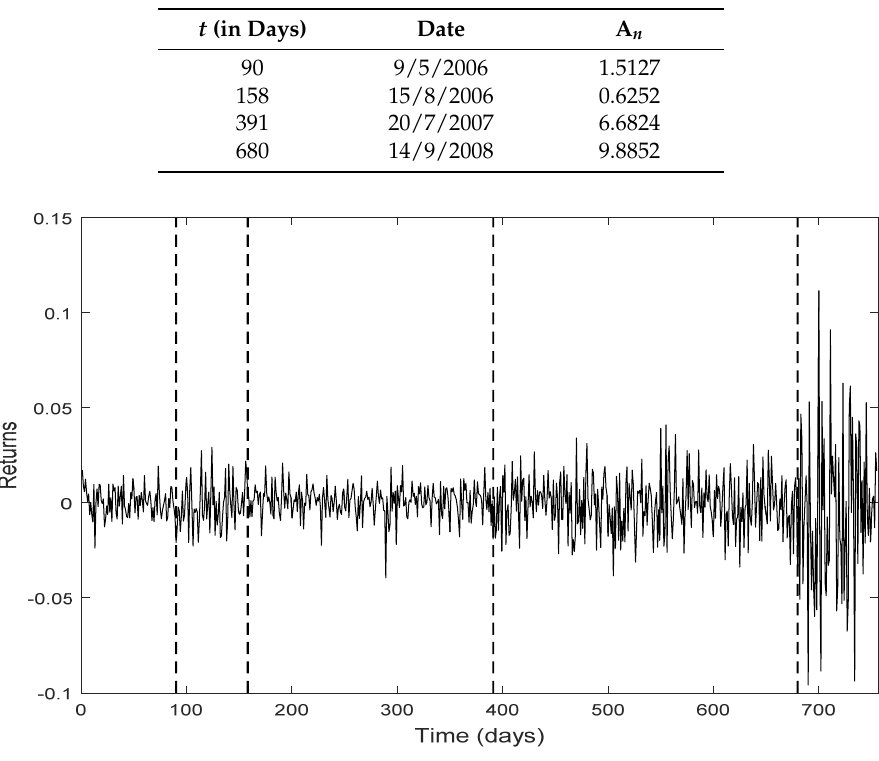
Figure 3. Change points for the NASDAQ return time series during the period